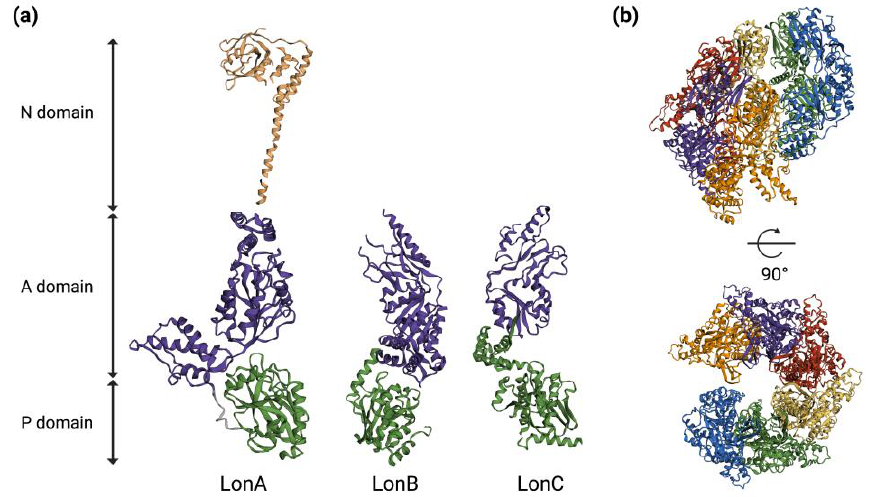
Figure 2. Three-dimensional structures of Lon protease. ( a ) Representative 3D models of single protomers of LonA (PDB ID: 6u5z & 3ljc) of E. coli , LonB of Thermococcus onnurineus (PDB ID: 3k1j) and LonC of Meiothermus taiwanensis (PDB ID: 4fw9). ( b ) Cryo-EM structure of LonA in E. coli (PDB ID: 6u5z) without a substrate. Six different colors represent six chains that form the hexamer. The 3D structures and PDB IDs were adapted from Wlodawer et. al., 2022 [38]. P = Protease; A = ATPase; N = N-terminal.